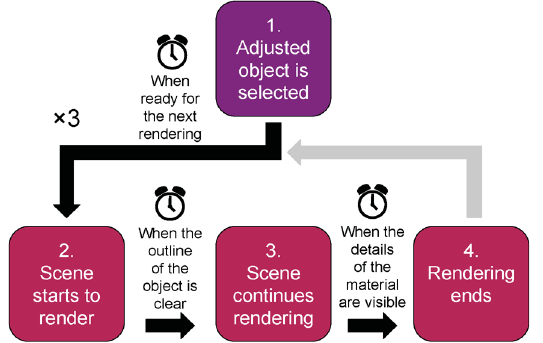
Fig. 3 Single scene procedure in the user study. Boxes are stages and arrows are participant’s actions triggering transitions to other stages. Clocks represent points where the system saved timing.